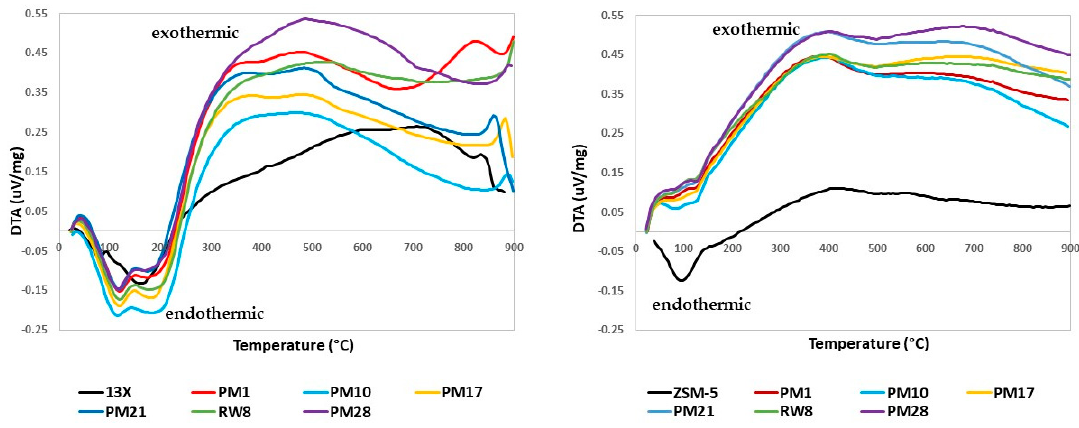
Figure 4. DTA curves of 13X ( left ) and ZSM-5 ( right ) zeolites after adsorption of water from different areas inside the SIN.